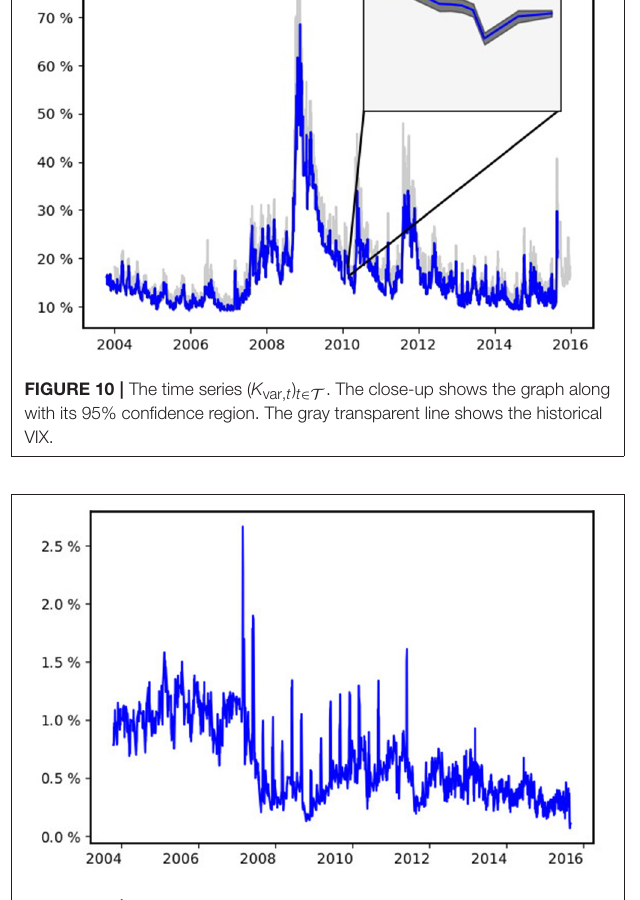
T , i.e., the relative error of the VIX ∈